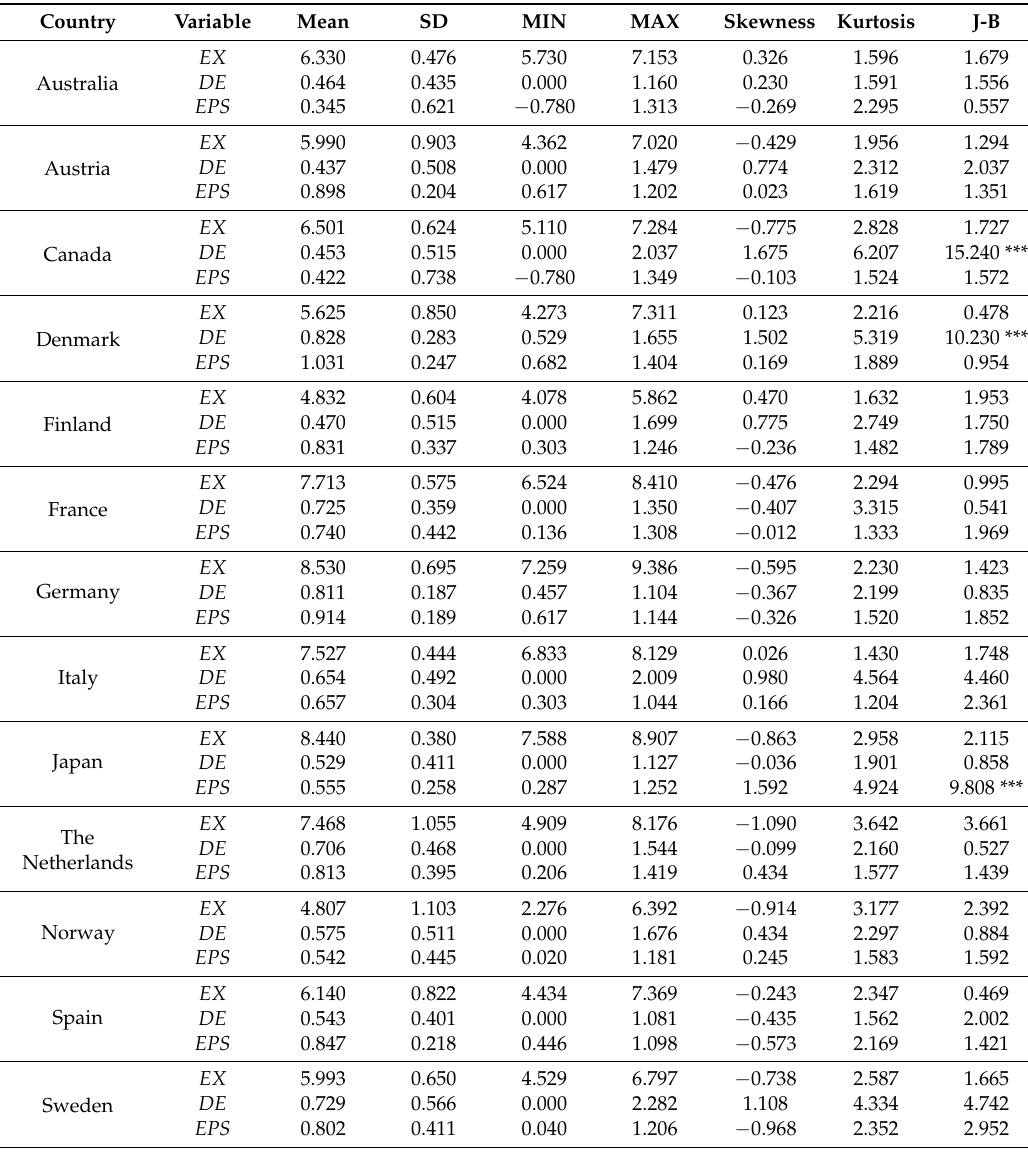
Table 1. Descriptive Statistics (Variables in Natural